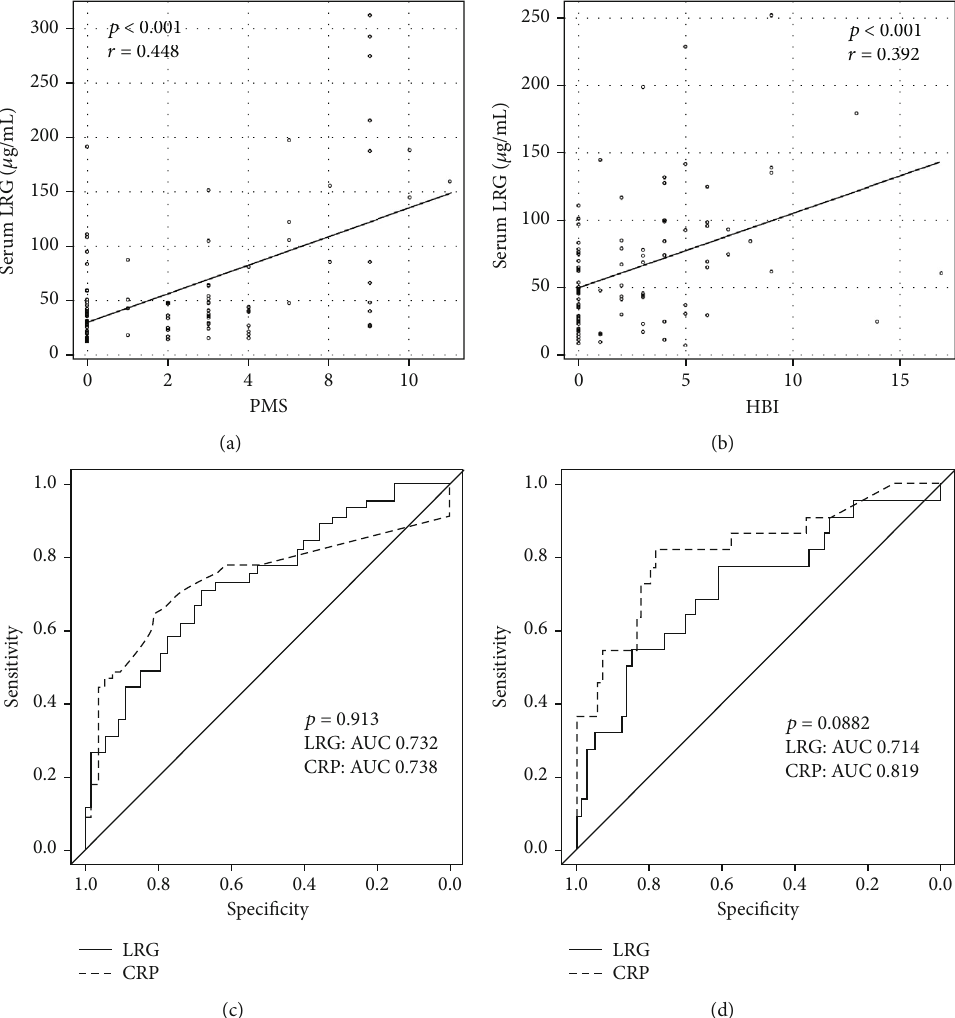
Figure 3: E ffi cacy of the serum leucine-rich alpha-2 glycoprotein (LRG) level as a biomarker for ulcerative colitis, assessed using the partial Mayo score (PMS), (a) and for Crohn ’ s disease assessed using the Harvey-Bradshaw index (HBI) (b). Receiver operating characteristic (ROC) curves for the serum LRG and C-reactive protein (CRP) levels, as evaluated according to the MS in ulcerative colitis (c) and the HBI in Crohn ’ s disease (d). Values of the area under the ROC curve (AUC) are shown. Clinical remission was de fi ned as MS ≤ 2 in UC and HBI < 5 in